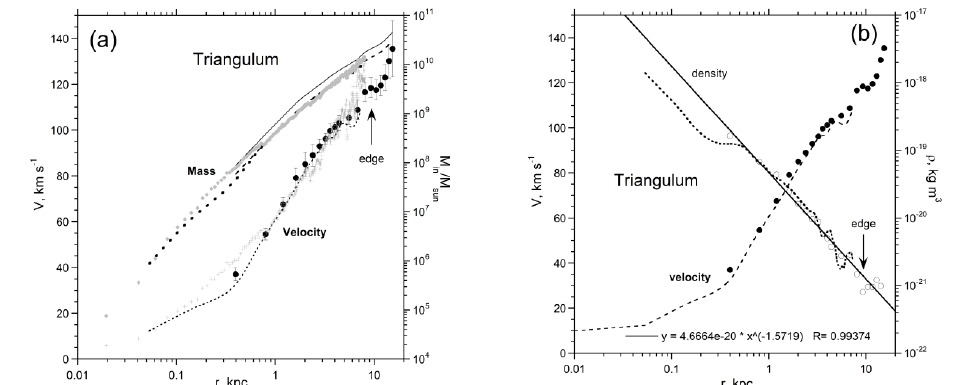
Figure 5. Comparison of three datasets on Triangulum to calculate mass ( a ) and density ( b ) vs. radius. RCs from Kam et al. [14] (grey crosses) were used to calculate mass (grey diamonds). RCs of Sofue [61] (black dashed line) were used to calculate mass (heavy black dotted line) and density (black dotted line). RCs of Corbelli and Salucci [70] (black points with error bars) were used to calculate mass for c / a = 1 (solid line) and c / a = 0.1 (medium dashed line) and density for c / a = 0.1 (circles and solid line). Agreement is good and the masses extracted are similar. The fit to ρ is over all r of [70]. An abrupt drop off in density is not observed. RC data are limited to the visible disk.